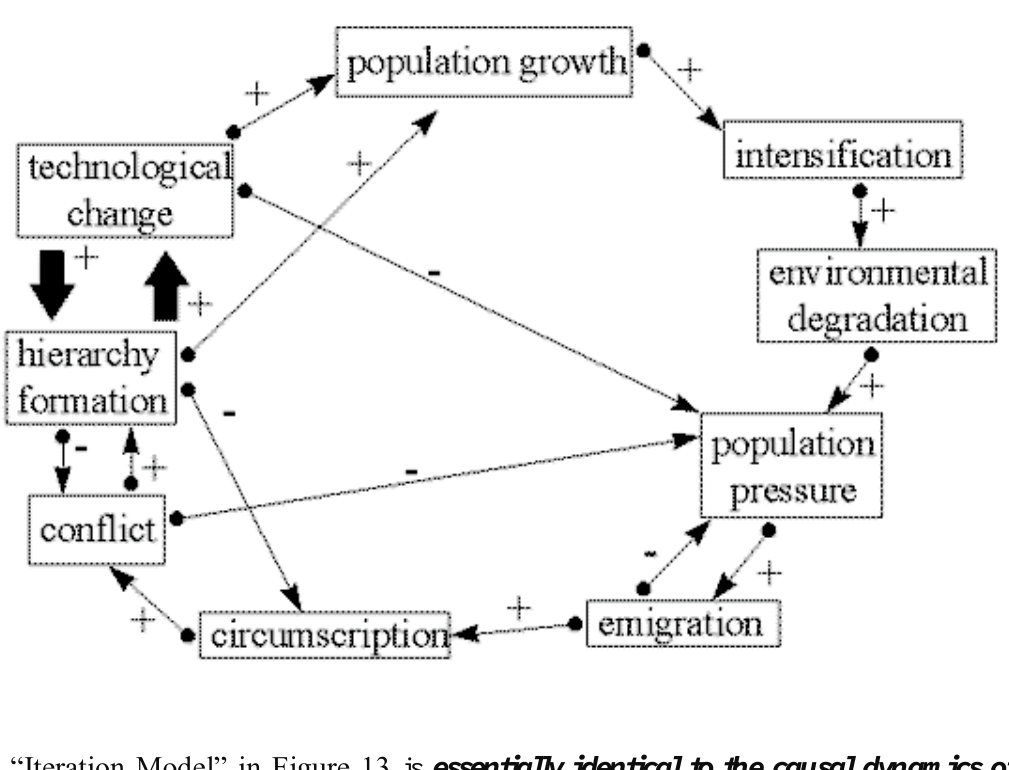
Figure 13. The Iteration